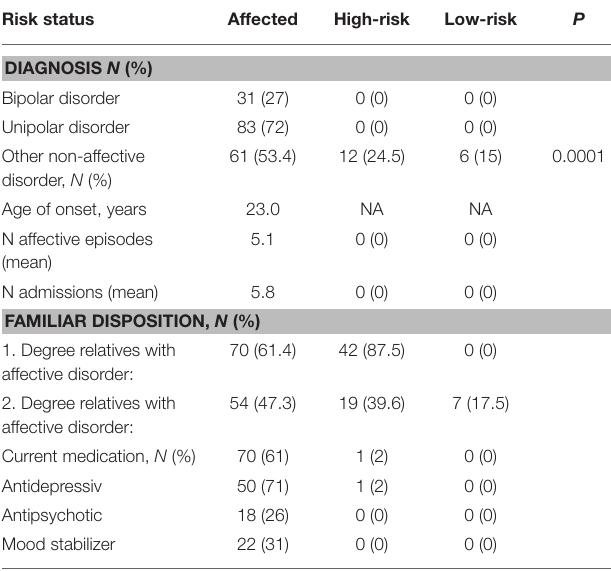
TABLE 4 | Diagnosis and medication status; affected, high-risk and low-risk monozygotic twin ( N =